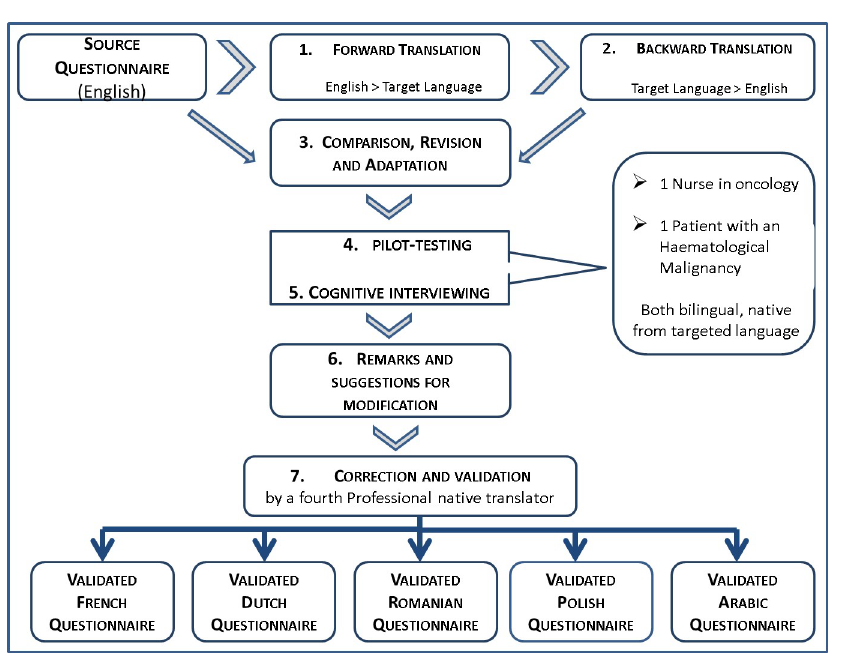
Fig 3. Translation and validation process of selected